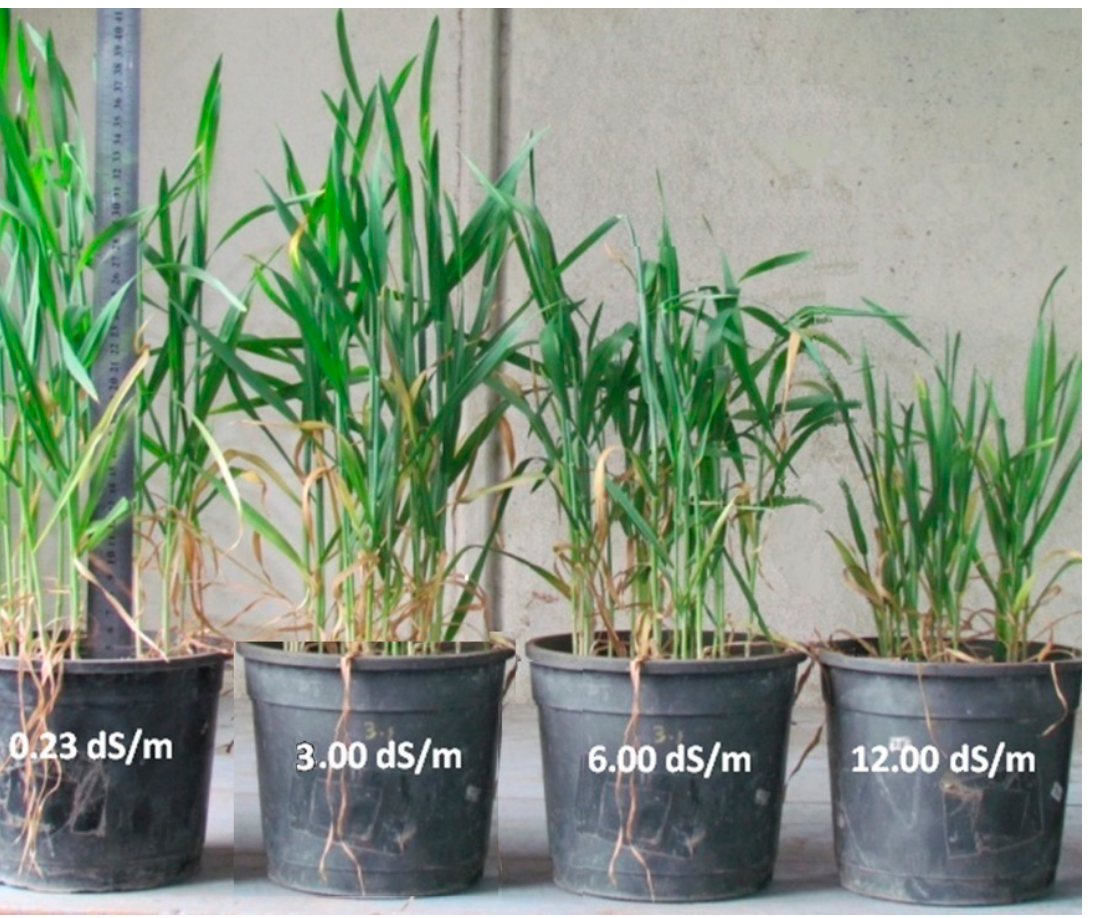
Figure 1. General view of the experiment of wheat plants after subjecting to 0.23, 3.0, 6.0, and 12.0 dS m − 1 salt stress for 56 days.